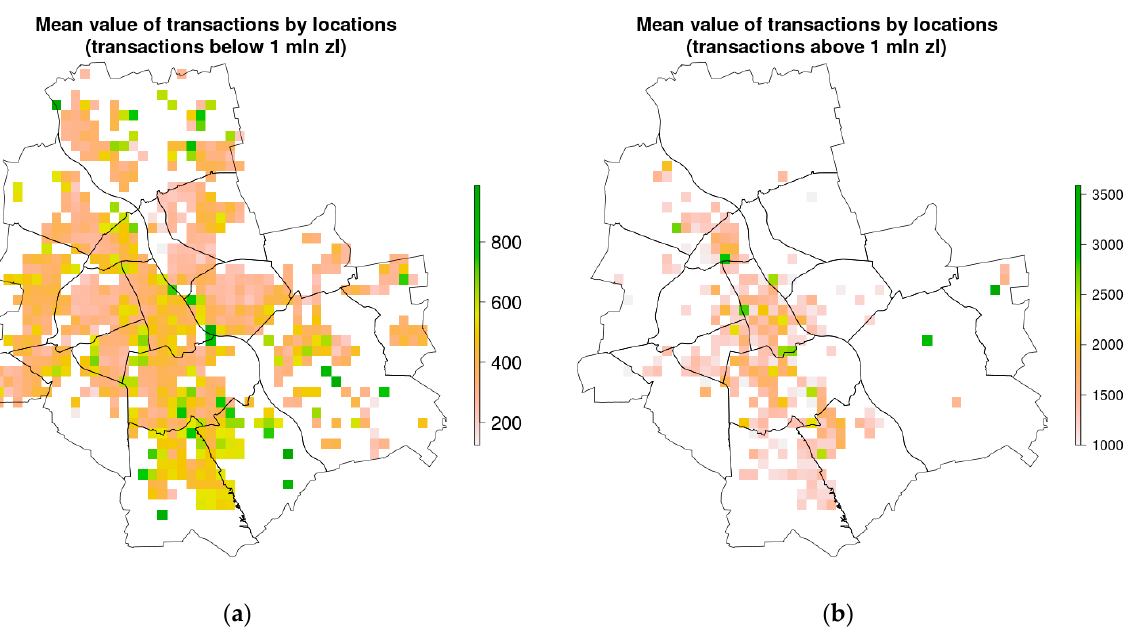
Figure 3. Spatial distribution of transactions by values: ( a ) below 1 mln PLN, ( b ) above 1 mln PLN to assess the spatial distribution of transactions and premium submarket location.